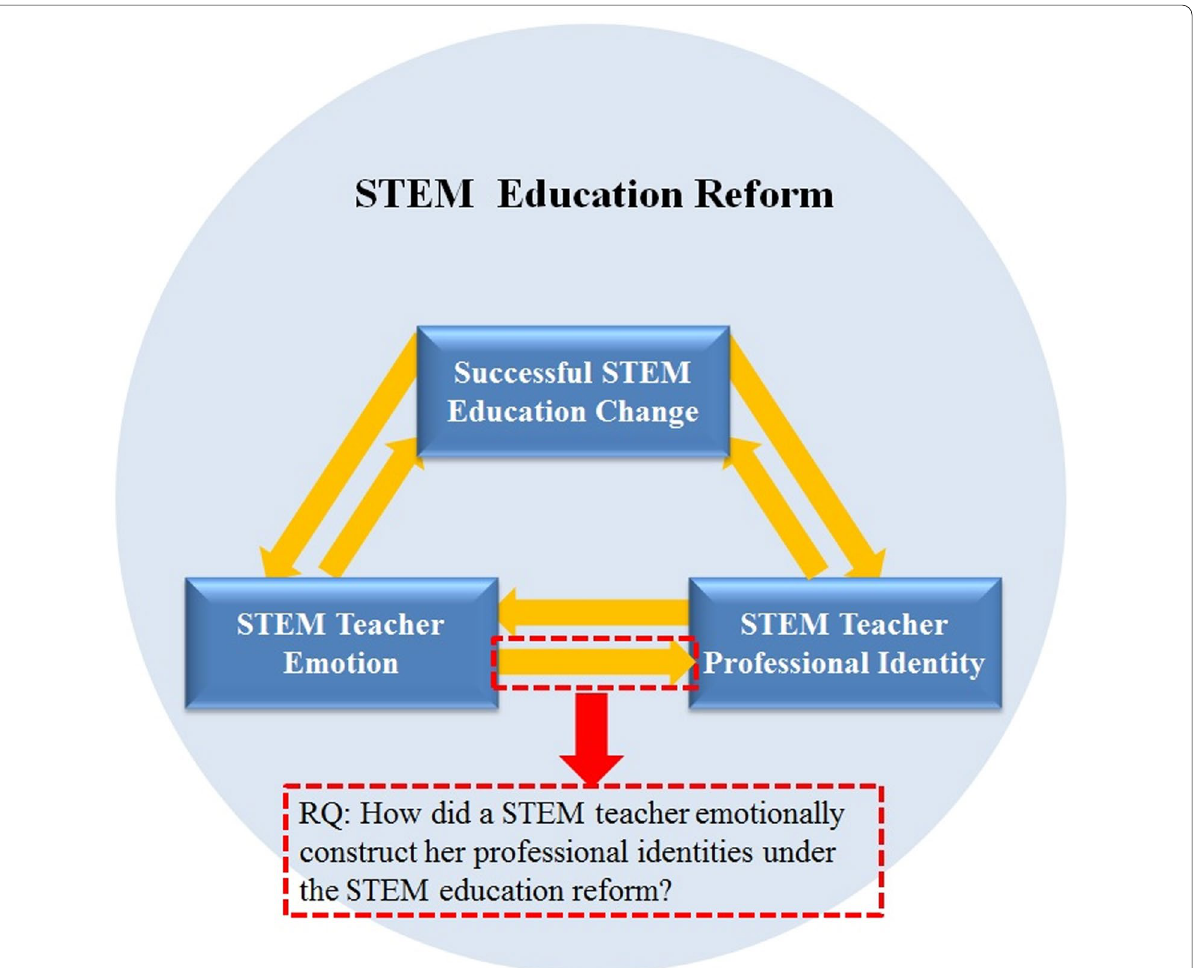
Fig. 1 A conceptual framework for the relationships among STEM teacher emotions, STEM teacher professional identities, and successful STEM education